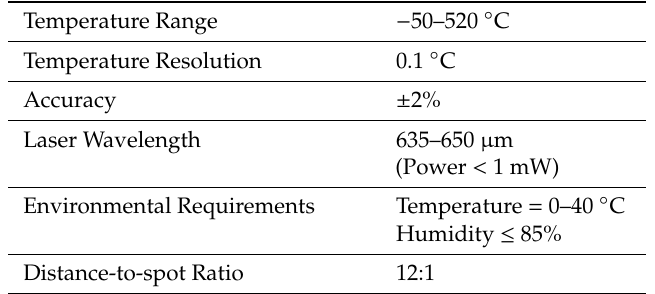
Table 2. Main Technical Specifications of the Infrared Thermometer.